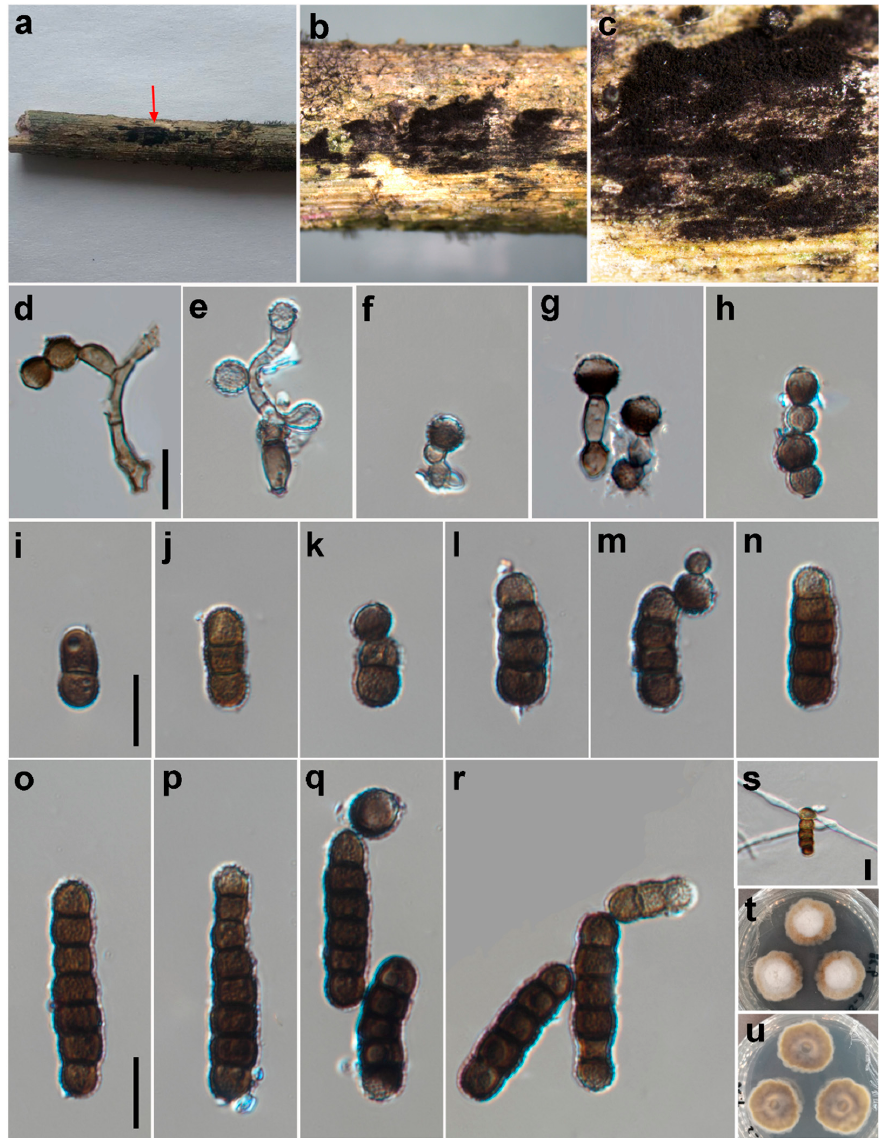
Figure 2. Torula chinensis (HKAS 126509, holotype). ( a – c ) Colonies on the natural substrate, arrows indicate the locations of colonies. ( d – h ) Conidiophores, conidiogenous cells and conidia. ( i – p ) Conidia. ( q , r ) Conidia in catenated chain. ( s ) Germinated conidium. ( t , u ) Culture on PDA from the surface and reverse. Scale bars: ( d – s ) = 10 µm. Scale bar of d applies to ( d – h ). Scale bar of i applies to ( i – n ). Scale bar of o applies to ( o – r ).